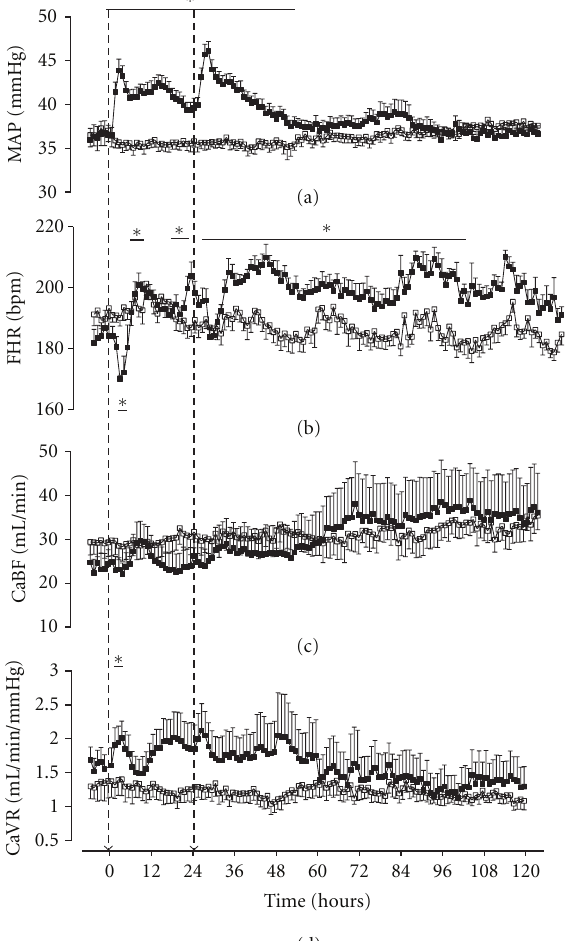
(d) Figure 1: Time sequence of changes in mean arterial pressure (MAP), fetal heart rate (FHR), carotid blood flow (CaBF), and carotid vascular resistance (CaVR) in 0.7 gestation fetuses after two maternal intramuscular injections of either saline (open squares, n = 7) or dexamethasone (filled squares, n = 8). Dexamethasone induced a significant increase in MAP after each injection, and pressure was elevated for 50 hours. FHR fell acutely after each injection, and there was a sustained period of tachycardia after the second injection. There was a tendency for CaBF to fall initially, and this was associated with a significant rise in resistance. However, overall there were no marked di ff erences in cerebral perfusion and resistance. Data are shown from six hours before the first injection to 120 hours afterwards. The dashed arrows show the timing of injections. Data are one hour averages, mean (SEM), ∗ P < 0 . 05.